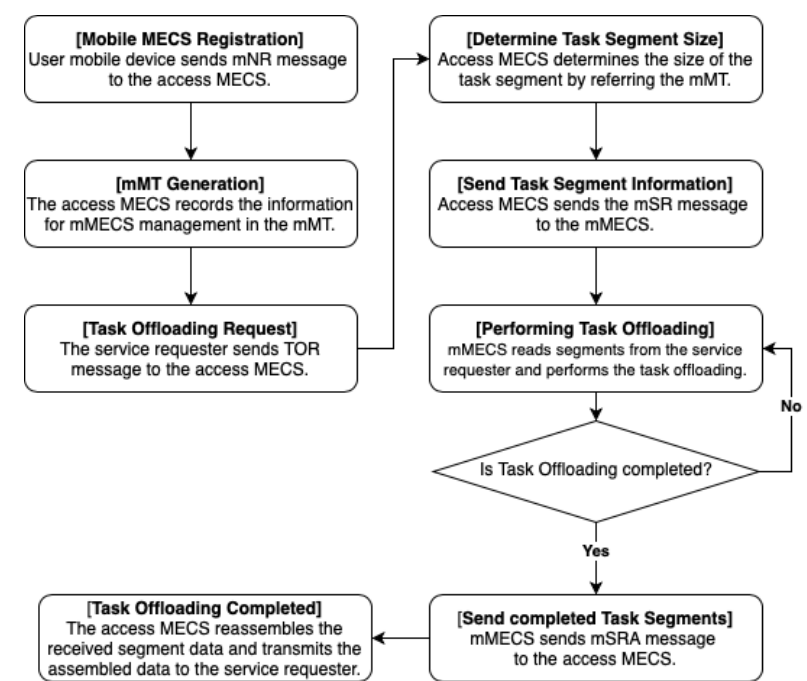
Figure 9. Flow Chart of the Mobile Personal Multi-Access Edge Computing Architecture.